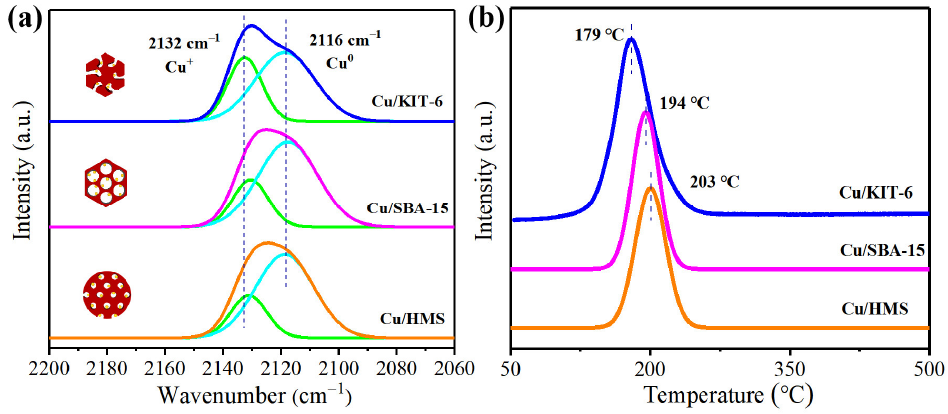
Figure 4. ( a ) In situ DRIFTS analysis of sequential adsorbed CO over Cu/KIT-6, Cu/SBA-15, and Cu/HMS catalysts; ( b ) H 2 -TPR analysis of Cu/KIT-6, Cu/SBA-15, and Cu/HMS catalysts.